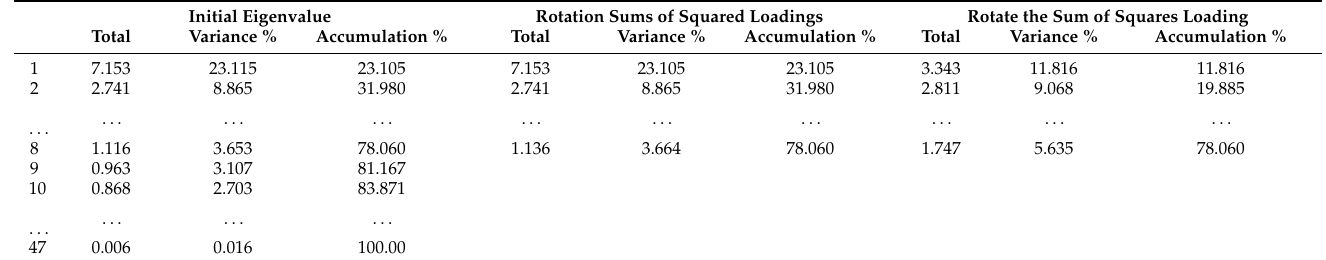
Table 2. Total variance.